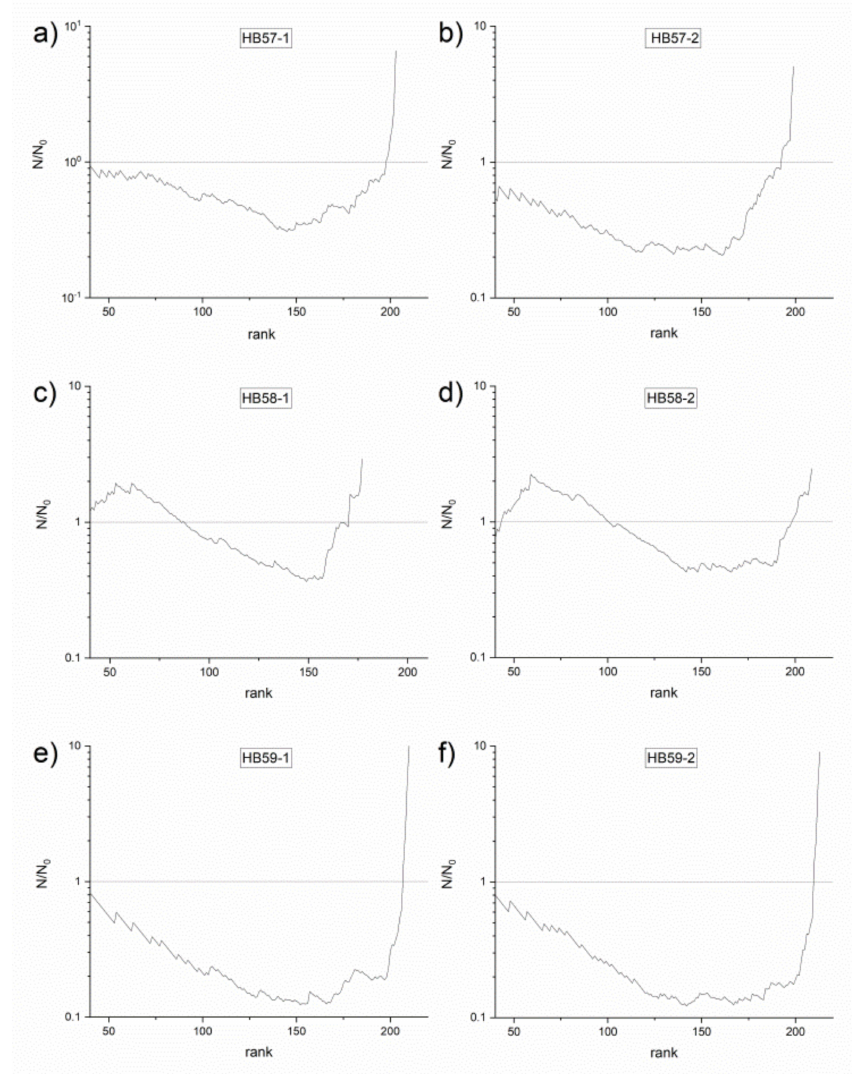
Figure 4. Abundance ratio plots in rank order illustrating the deviation of empirically identified abun- dances from an ideal exponential function with the rank-dependent value N 0 related to Equation (2): ( a ) sample HB57-1 (coal seam), ( b ) sample HB57-2 (coal seam), ( c ) sample HB58-1 (bright sediment), ( d ) sample HB58-2 (bright sediment), ( e ) sample HB59-1 (top soil), ( f ) sample HB59-2 (top